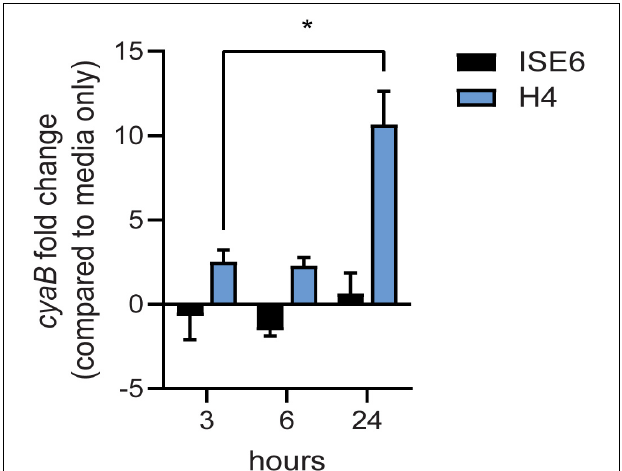
FIGURE 6 | cyaB expression is induced with mammalian H4 cell co-culture. Borrelia burgdorferi was co-cultured with ISE6 tick cells or H4 mammalian cells. qRT-PCR was performed on samples collected at 3, 6, and 24 h co-incubation. flaB was used as an endogenous control. Shown is the average and standard error of four biological replicates. Statistical analysis was done using two-way ANOVA with Tukey correction, * p -value < 0.05.